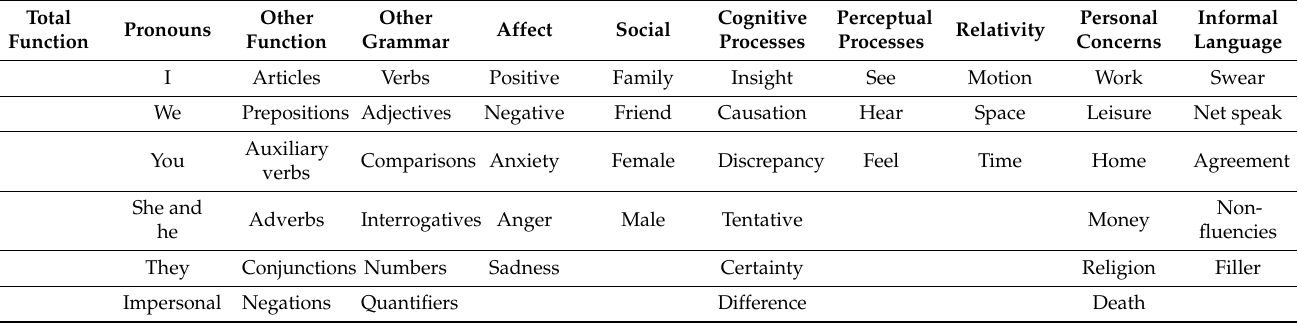
Table A1. Classification of function words in LIWC Dictionary.